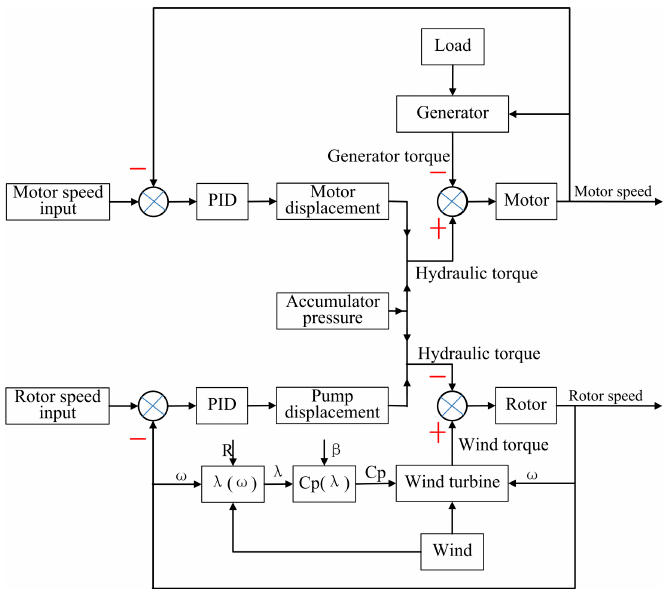
Figure 6. Speed control strategy of the rotor and motor.